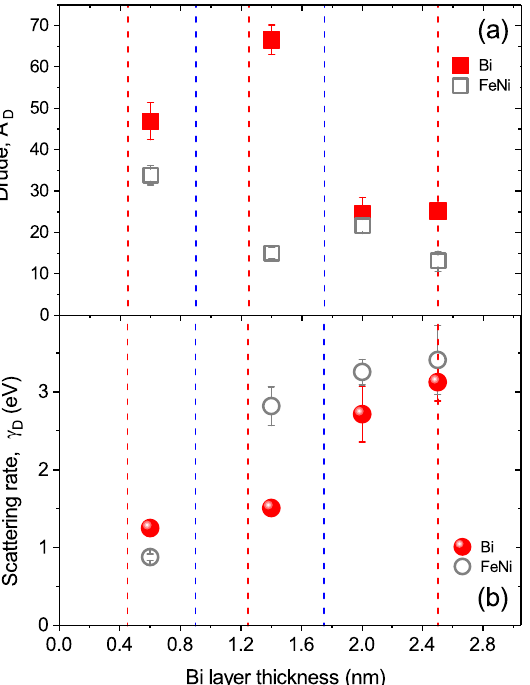
Figure 6. ( a , b ) Parameters of the Drude term ( A D and γ D ) for the Bi (filled symbols) and FeNi (empty symbols) layers in the [Bi(0.6,1.4,2.0,2.5nm)–FeNi(1.8nm)] MLF